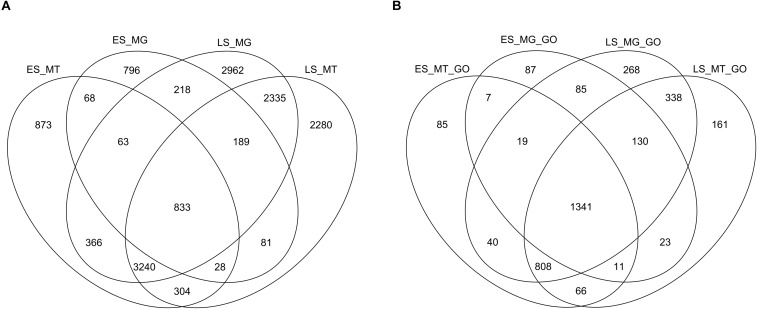
Venn diagrams displaying the functional overlap from the metagenomes (MG) and the metatranscriptomes (MT) from the early spring (ES) and the late spring (LS) periods based on two different levels of annotations (using EGGNOG-mapper) retrieved using UNIPROT: (A) protein name level and (B) GO (gene onthology) categories.